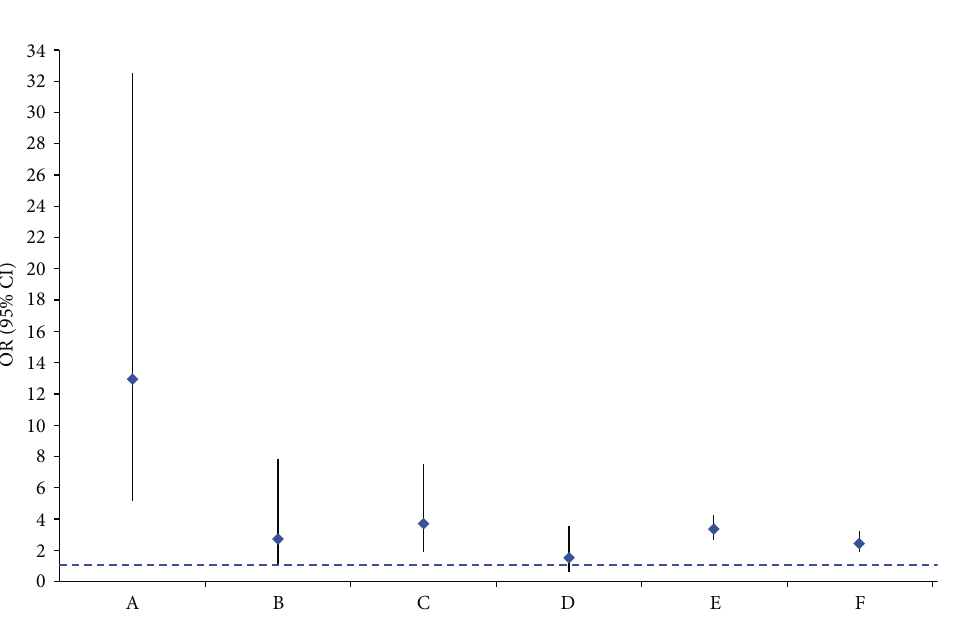
Table SM1: search strategy. Table SM2: PRISMA checklist. Table SM3: MOOSE checklist. (Supplementary Materials)